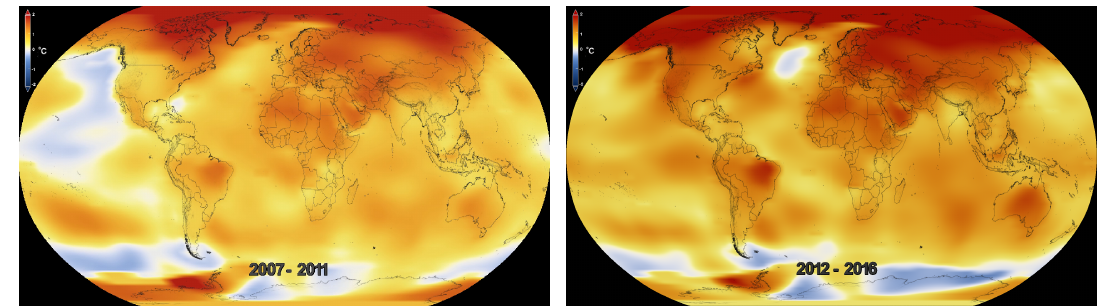
Figure 8. Global heat content between 1880 and 2017. The temperature anomalies are represented within a range from -2 degrees Celsius (dark blue) to +2 degrees Celsius (dark